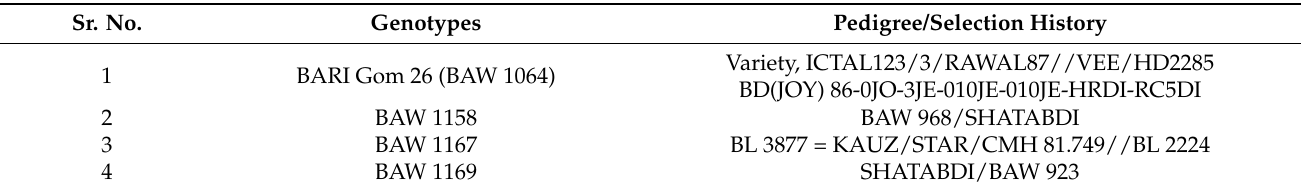
Table 4. Wheat genotypes and their pedigree/selection history used for the present study. Sr.